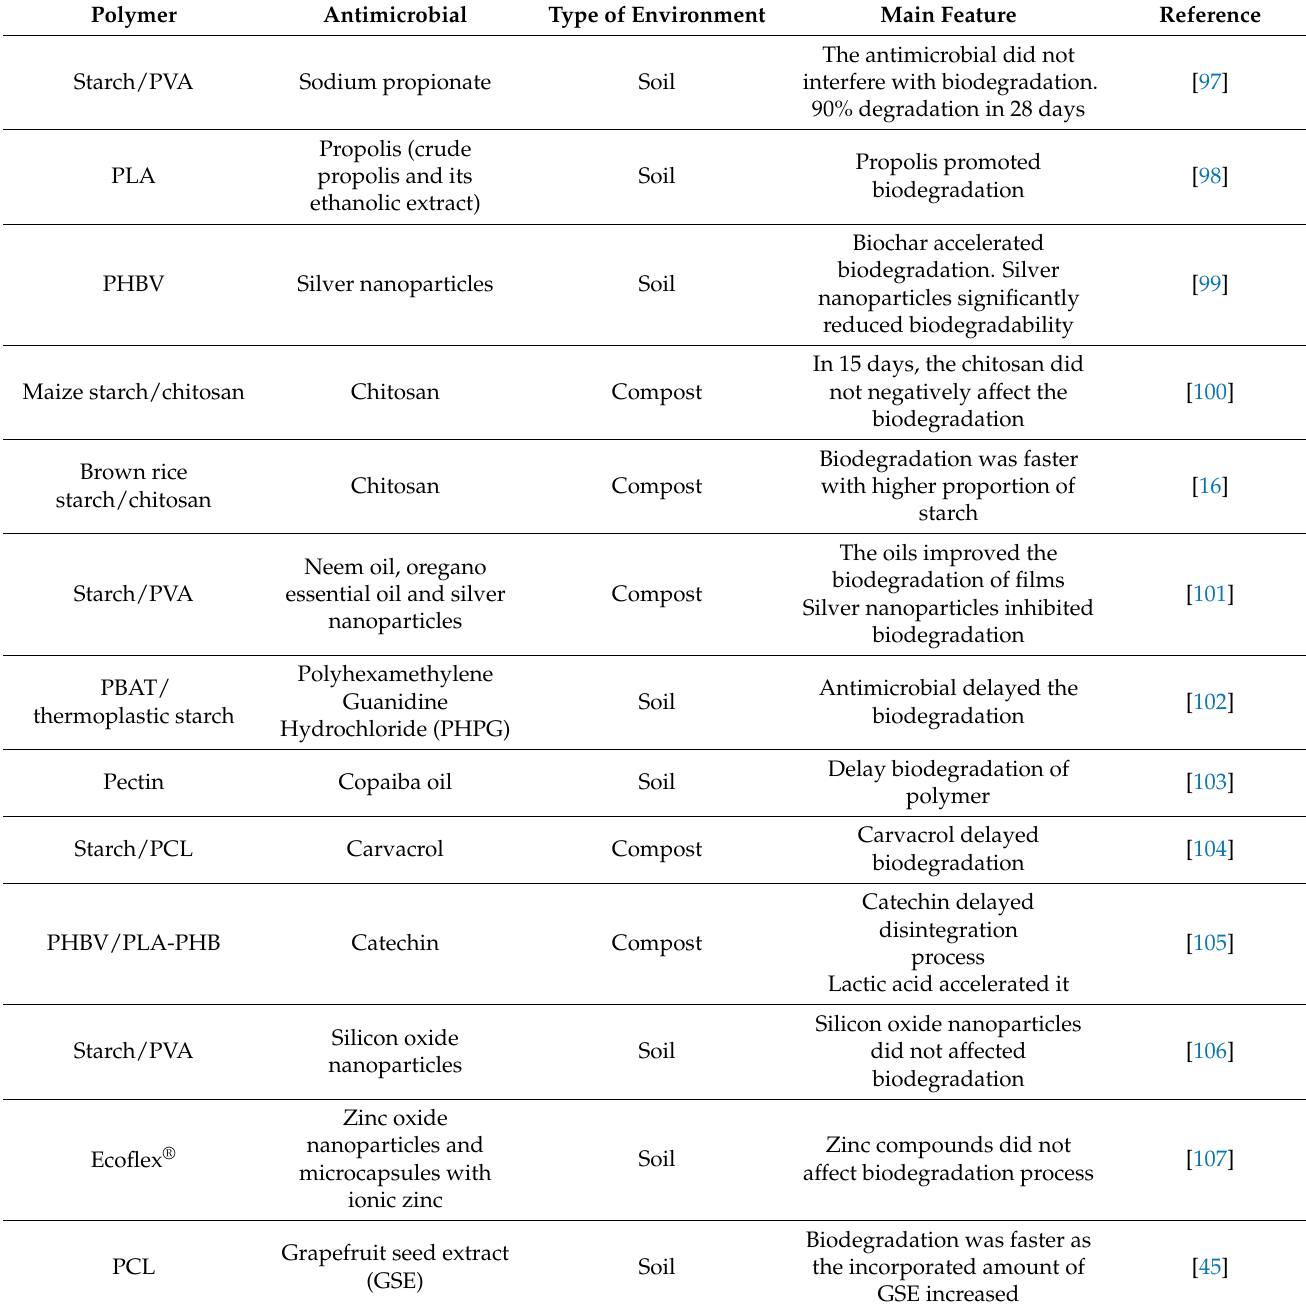
Table 5. Some effects of the incorporated antimicrobial compounds on the biodegradation of polymeric films.